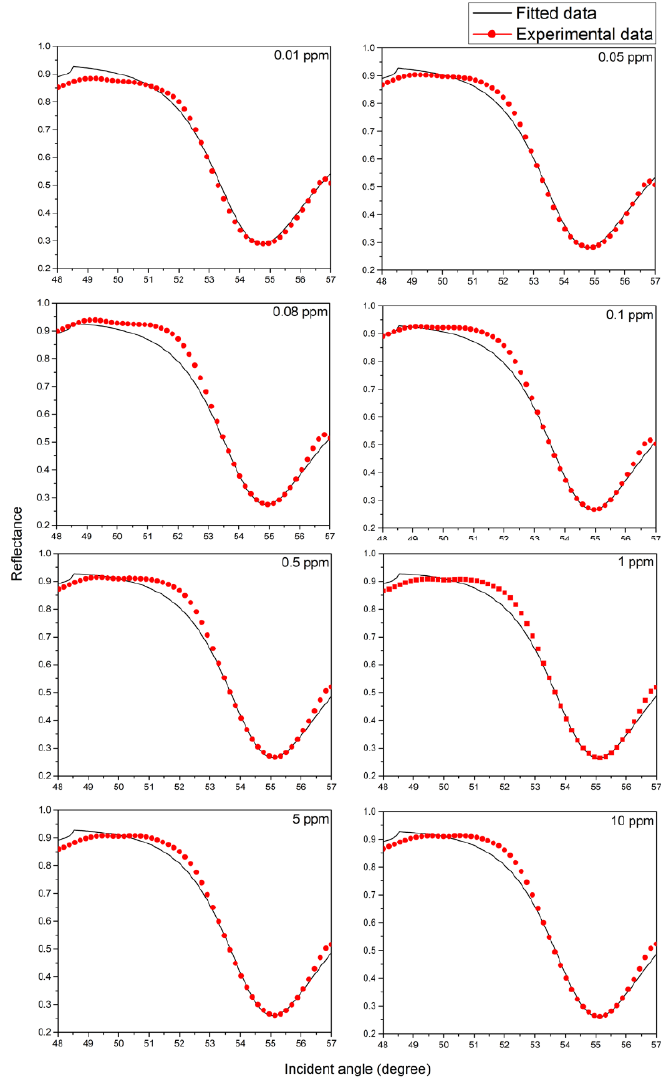
Figure 12. Fitted data and experimental data of SPR signal for NCC-based thin film in contact with copper ion from 0.01–10 ppm.